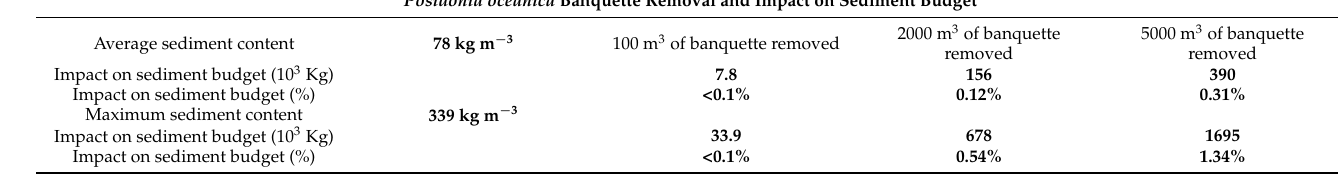
Table 3. Different scenarios on the sediment budget caused by removing banquette on Mari Ermi beach